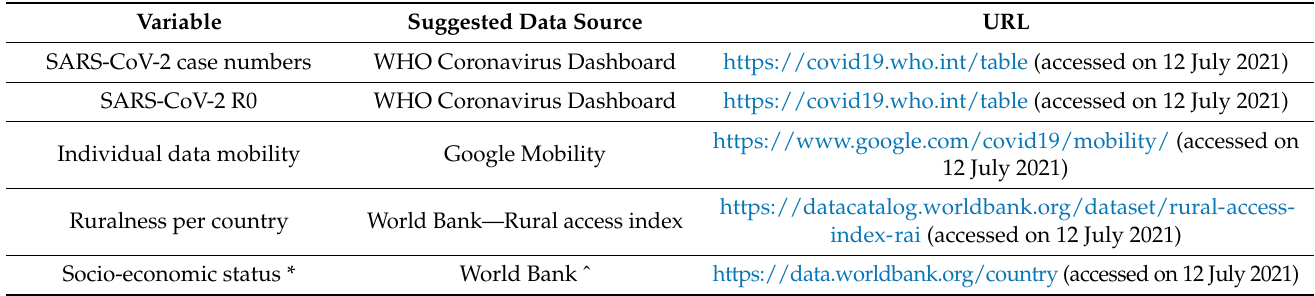
Table 5. Suggestions for data sources for the needed variables to test our methodology